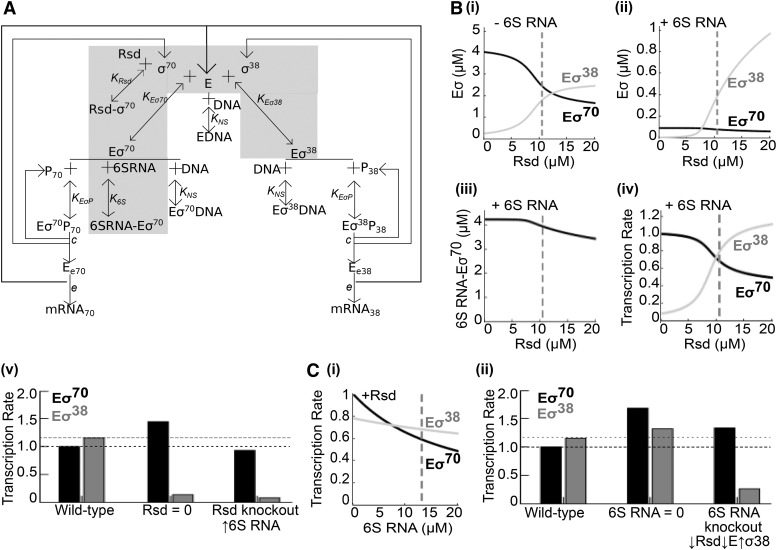
A mathematical model of Rsd and 6S RNA activity. (A) Schematic of the model. Shaded area represents reactions involved in holoenzyme formation (without DNA) (B) (i) Steady-state levels of Eσ70 (black) and Eσ38 (gray), computed from equations (1) - (9), as a function of total Rsd, when 6S RNA = 0. (ii) Same when total 6S RNA = 13 μM. (iii) Steady-state levels of the 6S RNA-Eσ70 complex, as a function of total Rsd. (iv) Steady-state rate of transcription from Eσ70 dependent promoters (black) and Eσ38 dependent promoters (gray), as a function of total Rsd. Vertical dashed lines represent wild-type cellular concentrations in stationary phase. (v) Steady-state rate of transcription from Eσ70 dependent promoters (black bars) and Eσ38 dependent promoters (gray bars) in the wild-type, absence of Rsd, and simulated Rsd knockout. (C) (i) Steady-state rate of transcription from Eσ70 dependent promoters (black) and Eσ38 dependent promoters (gray), as a function of total 6S RNA. Vertical dashed lines represent wild-type cellular concentrations in stationary phase. (ii) Steady-state rate of transcription from Eσ70 dependent promoters (black bars) and Eσ38 dependent promoters (gray bars) in the wild-type, absence of 6S RNA, and simulated 6S RNA knockout.